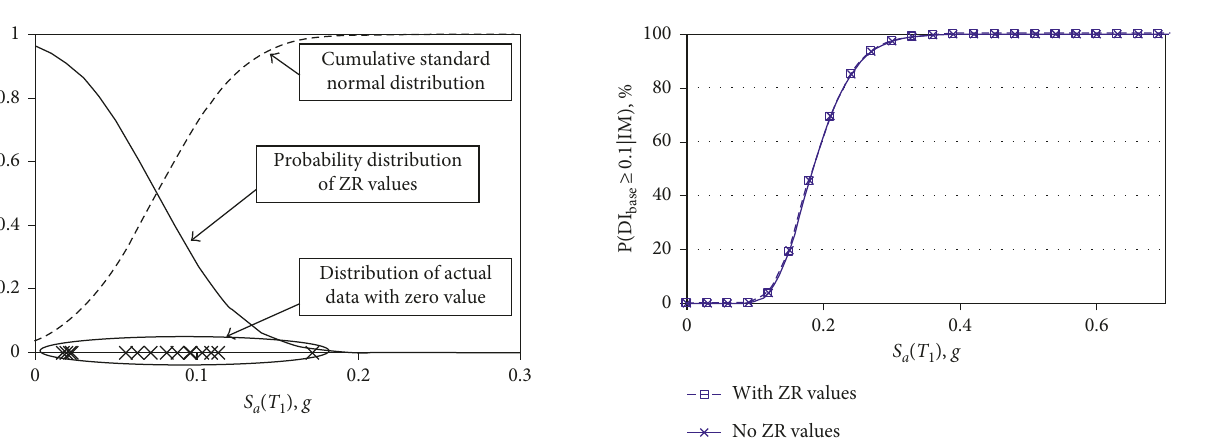
Figure 9: Actual distribution of zero response values for DI terms of IM � S a ( T 1 ) along with the fitted cumulative standard normal distribution and the probability distribution of ZR values.